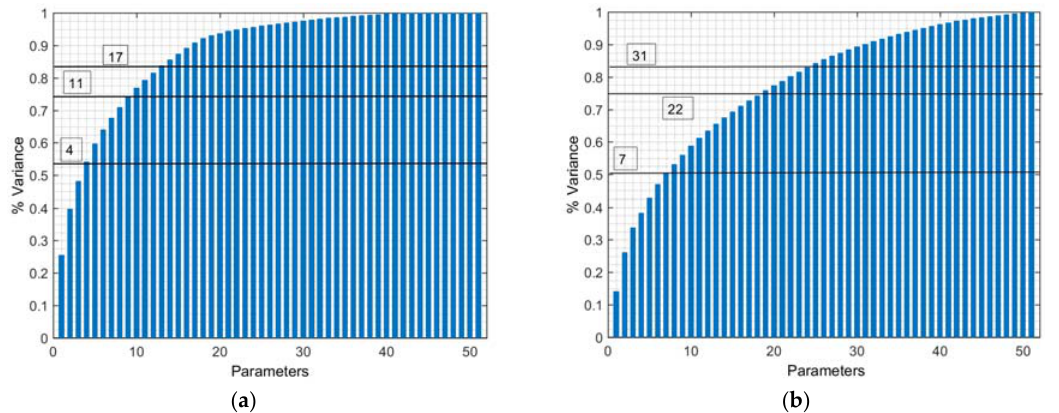
Figure 3. Accumulated sum of sensitivity indices: ( a ) Antibody Concentration ( b ) Other Measured Metabolites Concentration to 51 parameters in the CHO Model.